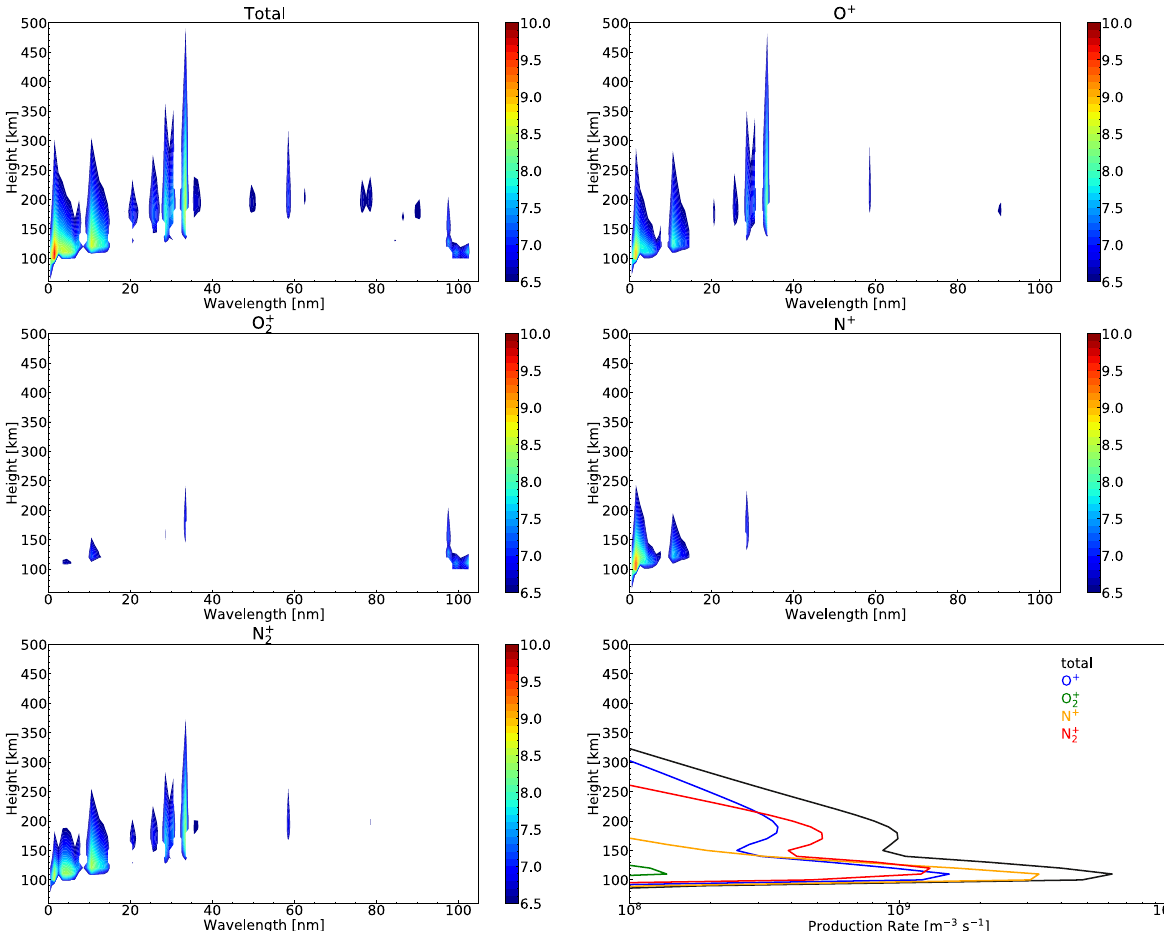
Fig. 6 Differences in ion production rate between the pre-flare and flare peak by GAIA with RUN-35. Differences in ion production rate between the pre-flare and flare peak at 130°E and 34°N calculated by GAIA with RUN-FS35 for the X1.1 class flare that occurred on November 8, 2013. Differences in the ionization rates for a total ion, b O + , c O 2 + , d N + , e N 2 + as a function of the wavelength of solar emission (unit: Log10 (W m − 2 nm − 1 ). f Differences in the altitude distribution of the ionization rates of each ion. The solid and dotted lines indicate the ionization rates of each ion at the flare peak (4:24 UT) and the pre-flare (4:00 UT), respectively